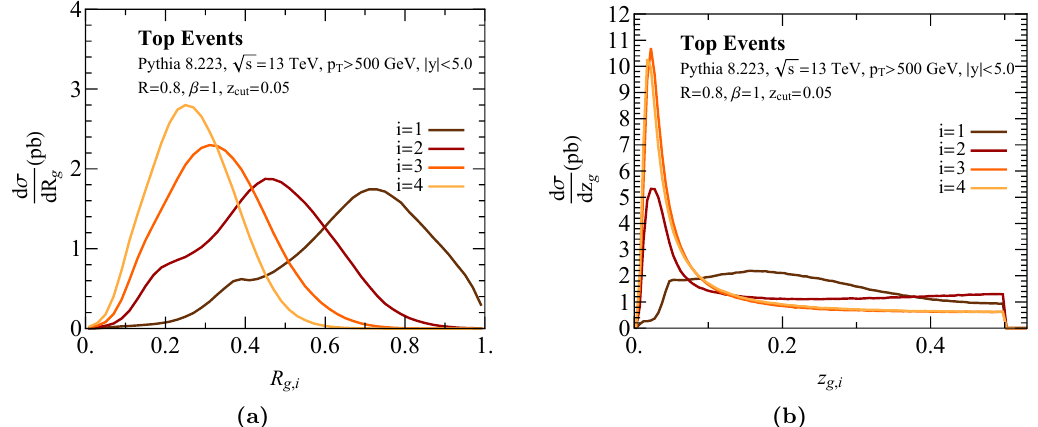
Figure 3. Distributions in the top jet sample of (a) groomed radius and (b) groomed momentum fraction for i = 1 ; 2 ; 3 ;